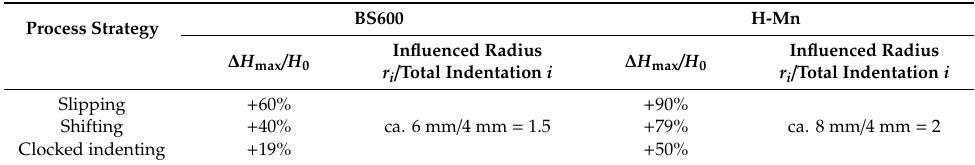
Table 2. Maximum hardness increase depending on the process strategy and ratio of influenced radius r i to total indentation